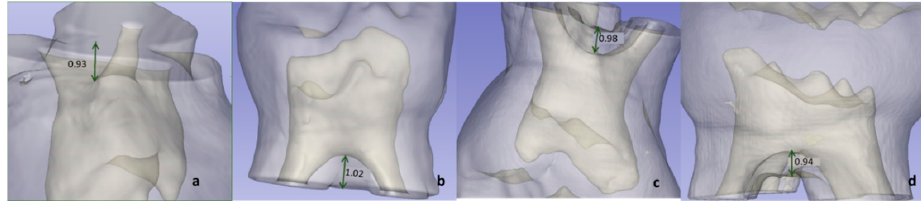
Figure 3. The green arrows indicate the measurement between the most convex spot from the pulp chamber floor to the root bifurcation (FD): P1MS ( a ); P1MI ( b ); P2MS ( c ) and P2MI ( d ). 2.4.3. Pulp Chamber Volume (PV), Dental Crown Volume (CV), and Volume Ratio (VR)